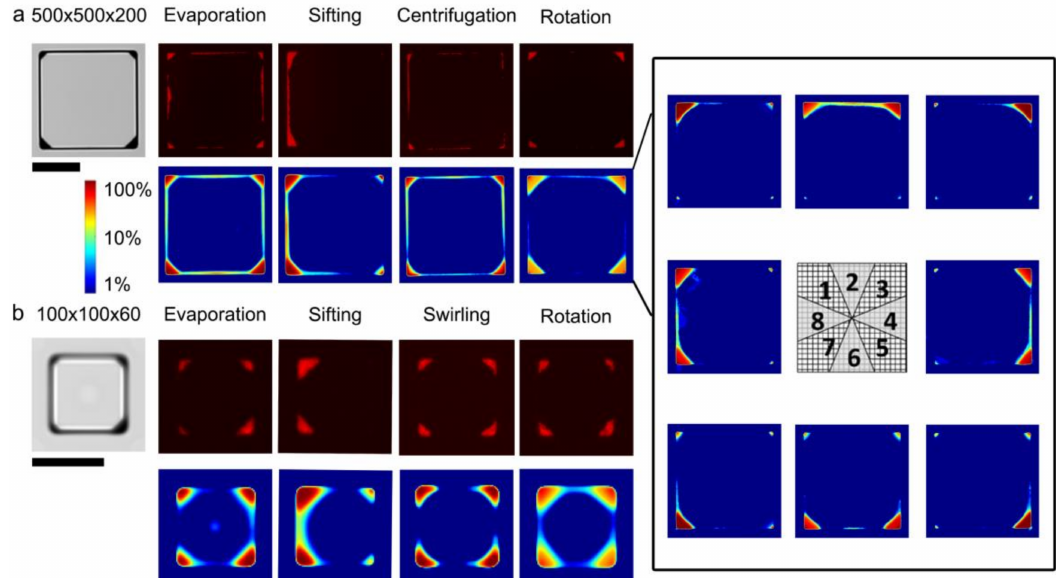
Figure 2. Analysis of microparticle deposition patterns. γ -Fe 2 O 4 microspheres were deposited into large microwells ( a ); scale bar = 250 µ m and small microwells ( b ); scale bar =100 µ m. Top rows: representative brightfield and fluorescence microscopy images; Bottom rows: Probability density maps colored with a logscale colormap indicating the pixel-wise likelihood of particle occupancy, processed from over at least 1200 or 19,000 microwells for large and small microwells, respectively. Right inset: probability maps extracted along octants of a microarray (center schematic, one representative map is shown from each octant) illustrating an angular gradient for rotationally deposited